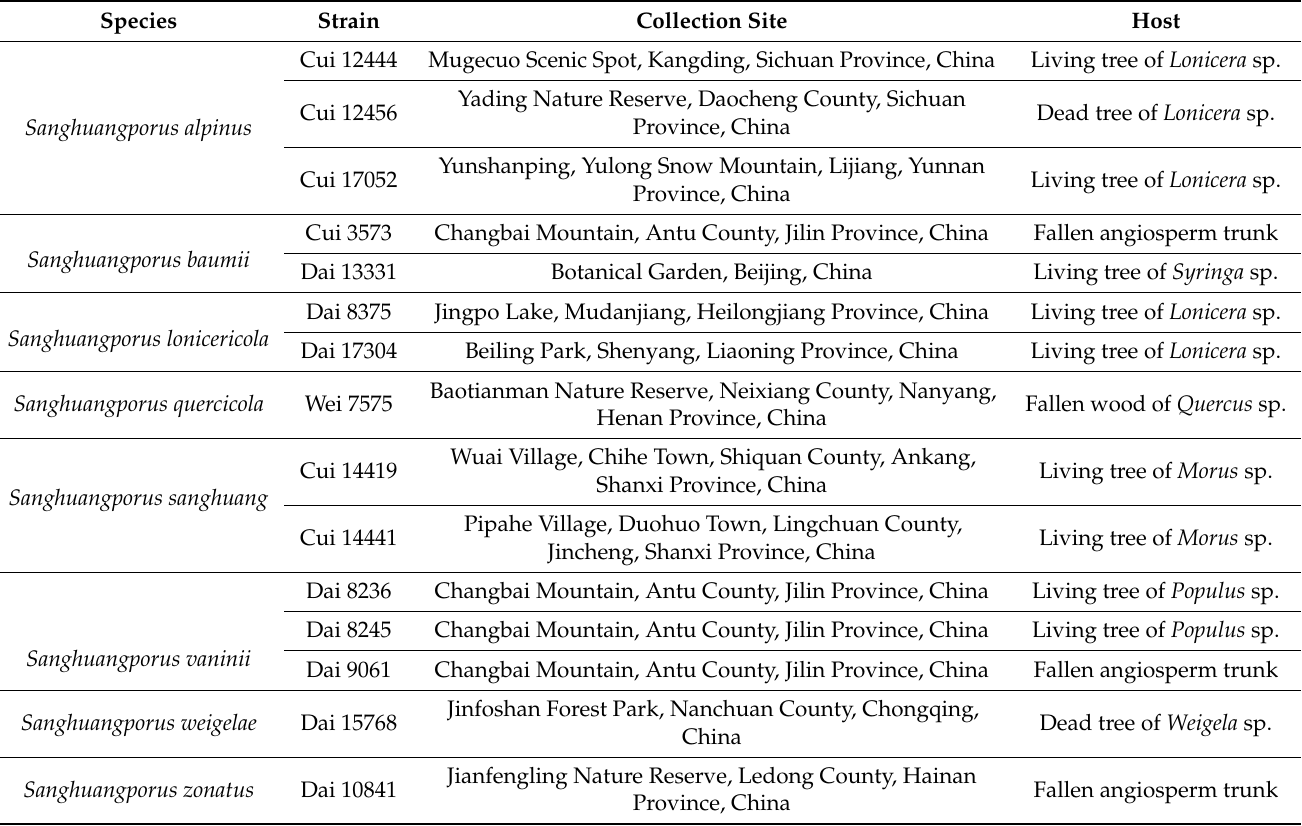
Table 1. Detailed information on strains, collection sites, and hosts of the Sanghuangporus species used in the present